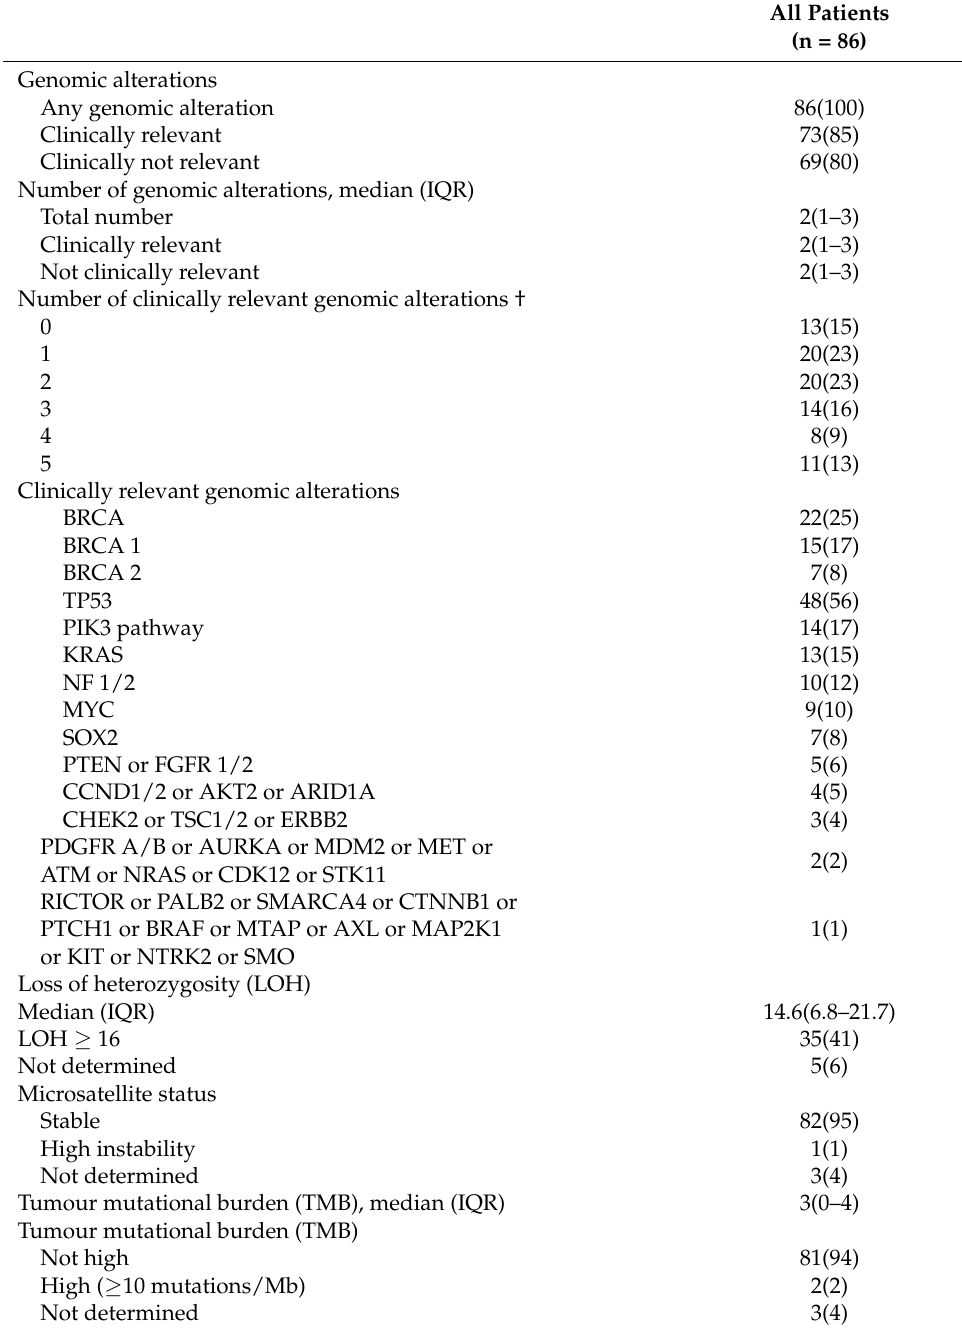
Table 2. The results of comprehensive genomic